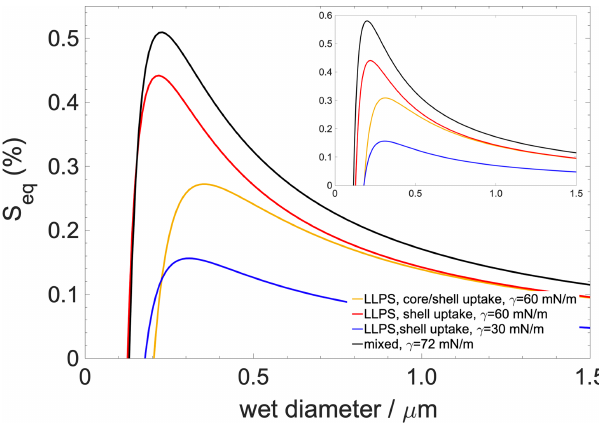
Figure 7. Köhler curves for a 50nm dry-diameter particle contain- ing 90% organics with 10% salt ( ( NH 4 ) 2 SO 4 ). The inset shows Köhler curves for a dry particle which contains organics only. Black curve: well-mixed case; blue curve: scenario 1 (hindered core up- take with concentration gradient); red curve: scenario 2 (hindered core uptake without concentration gradient); yellow curve: sce- nario 3 (unhindered core uptake without concentration